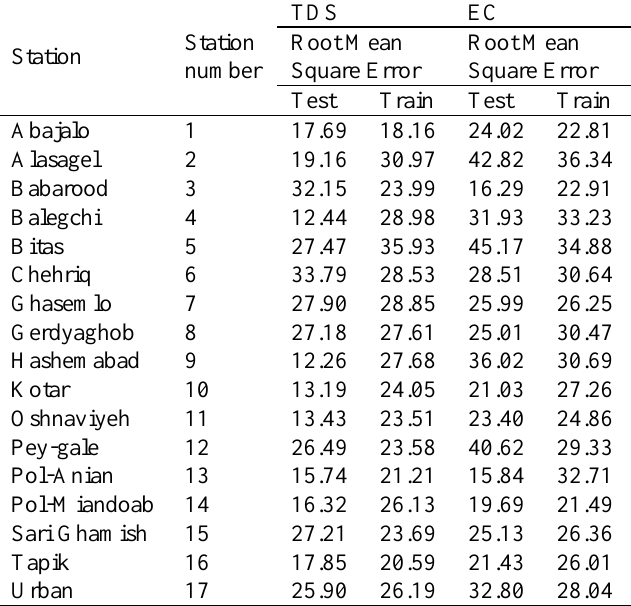
Table 2. The results of the study and verification of the model ARIMA in modeling EC and TDS